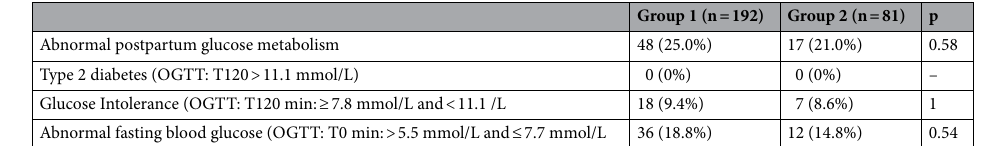
Table 2. Abnormal postpartum glucose metabolism. Data are presented as number